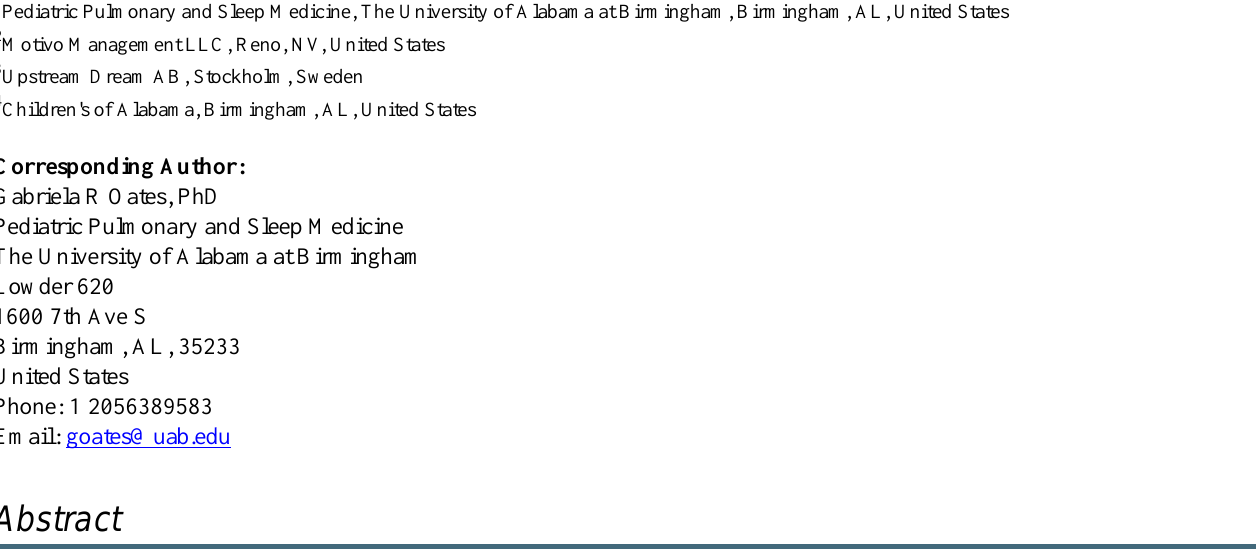
cystic fibrosis;